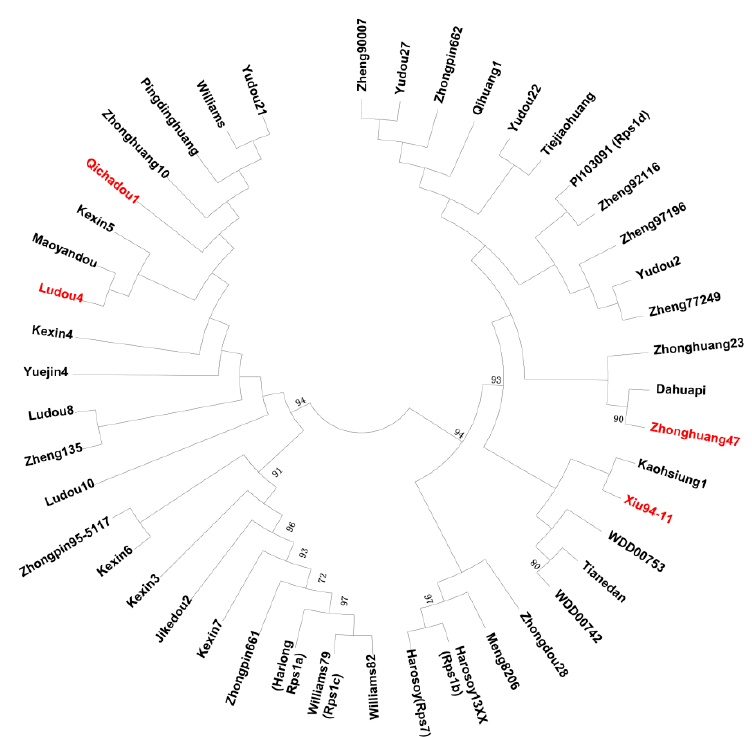
Figure 4. Phylogenetic tree constructed according to the neighbor-joining method using homozygous SNPs identified on chromosome 3 among 45 soybean genotypes, including cultivars and landraces.